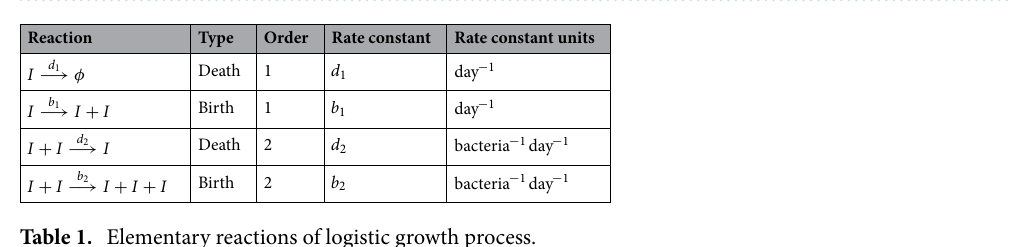
Figure 1. Model overview. ( a ) 2C model schematic. ( b ) Phase plot of 2C model. ( c ) Variations in 2C stochastic simulation (each region bounds mean ± SD of 50 simulations). ( d ) Human health outcome classification according to SA dynamics.